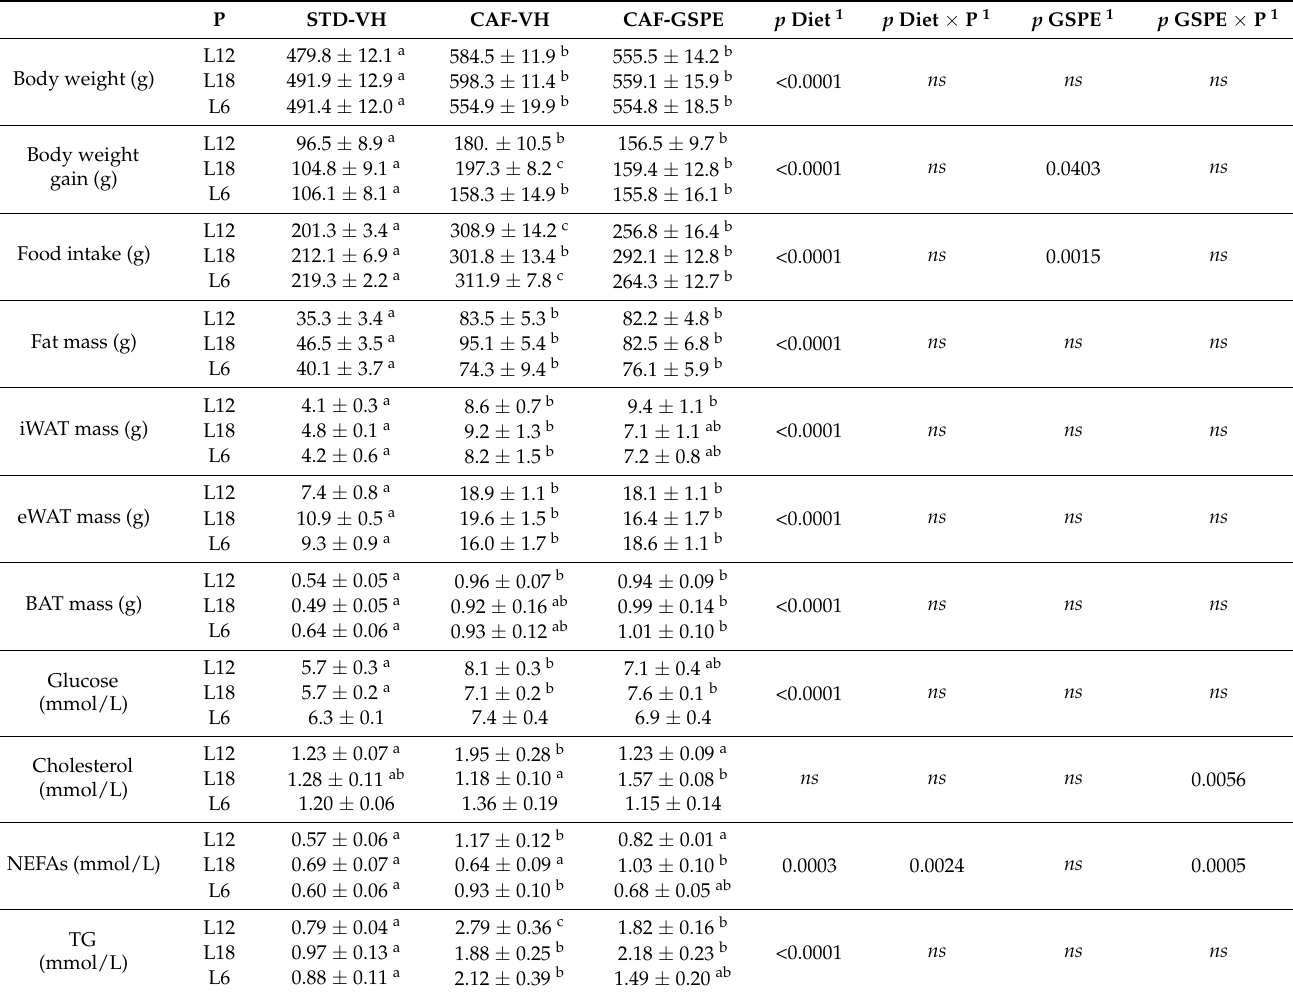
Table 1. Biometric and circulating